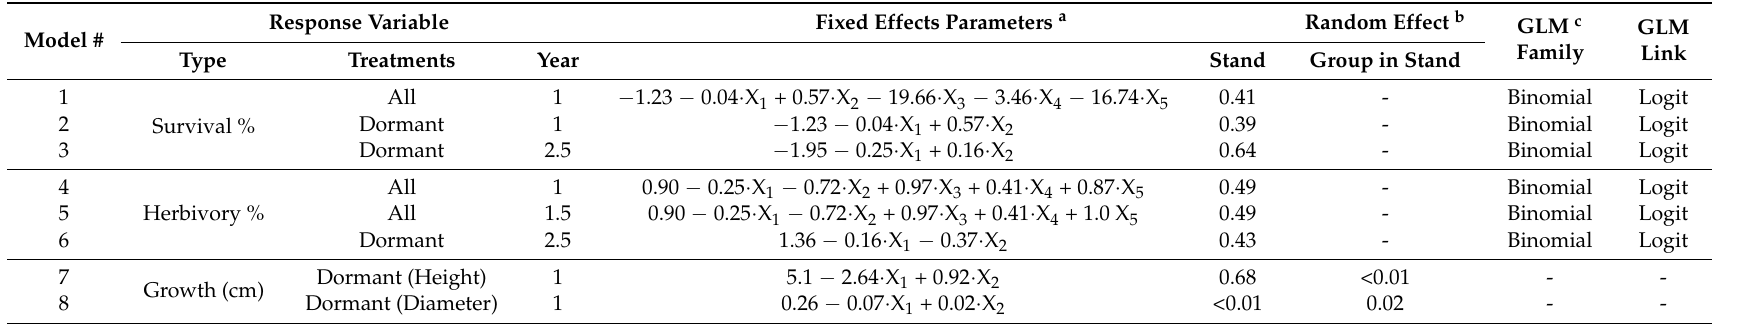
Table 2. Overview of linear mixed models used in this